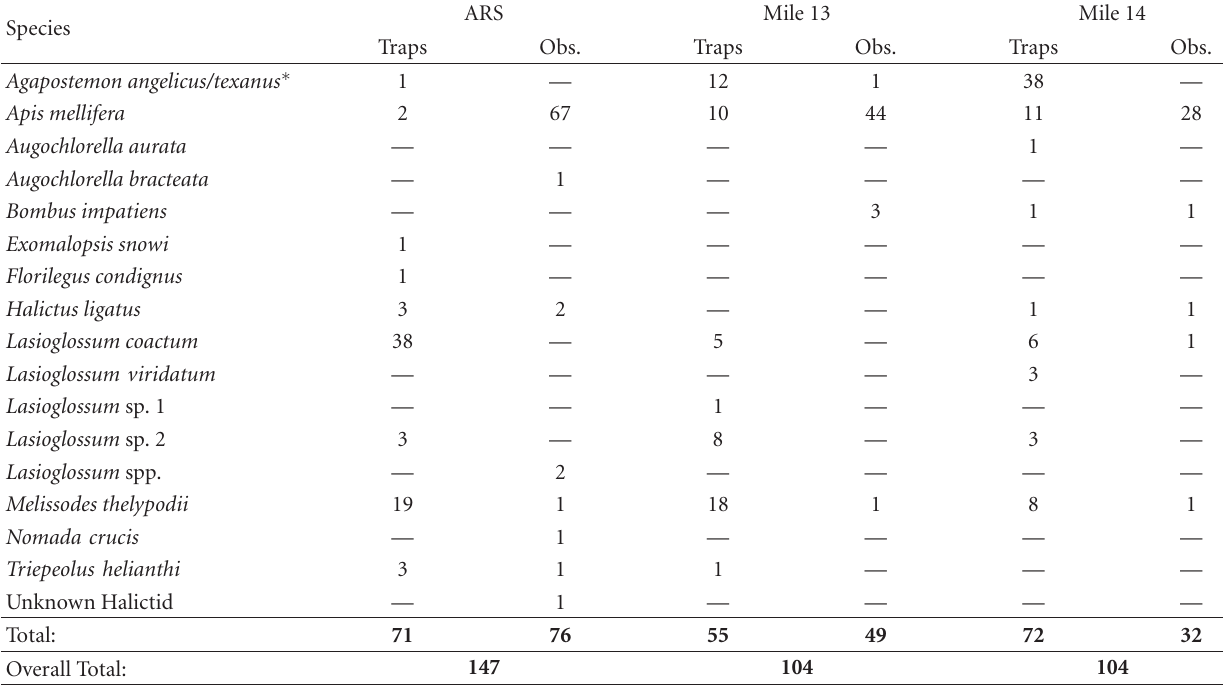
Table 1: Bee species collected from three Lower Rio Grande Valley watermelon fields during 2011. ARS Mile 13 Mile 14 Species Traps Obs. Traps Obs. Traps Obs.